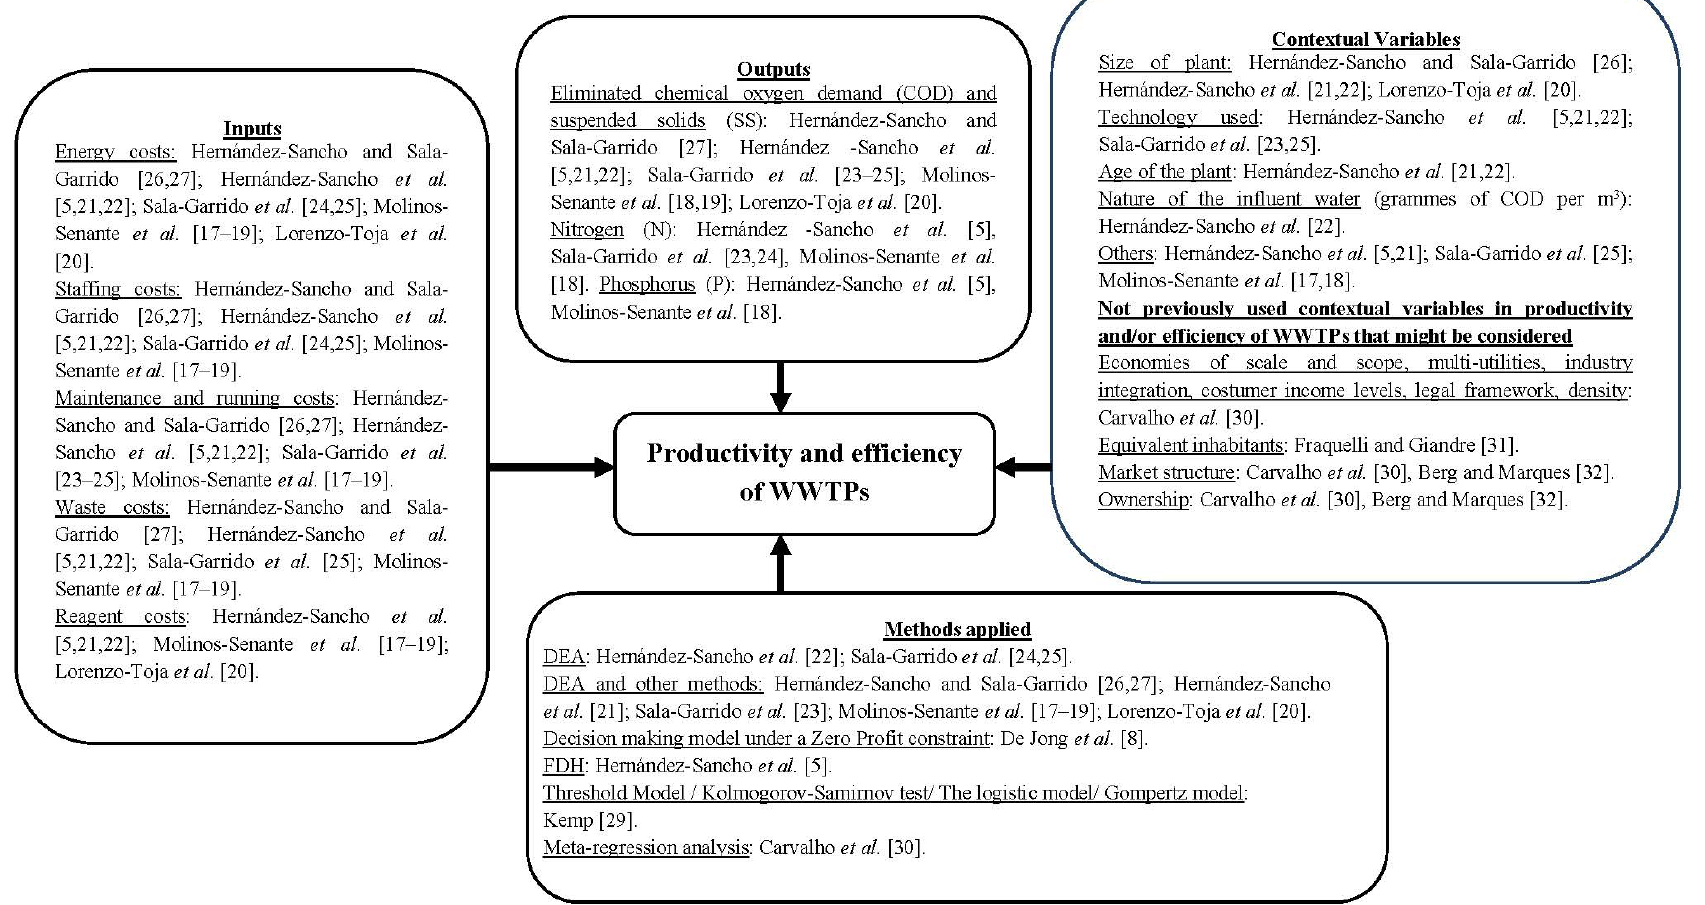
Figure 1. Synthesis of the variables previously used in the analysis of the productivity and/or efficiency of